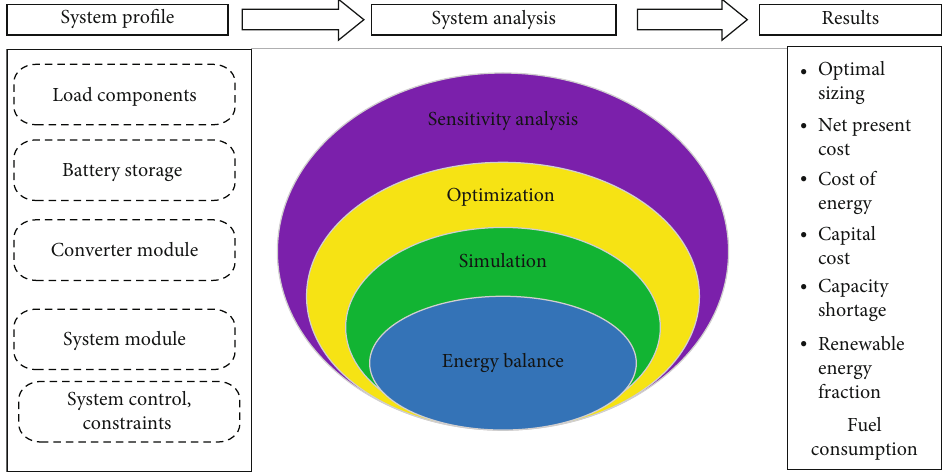
Figure 2: A detailed schematic representation of HOMER